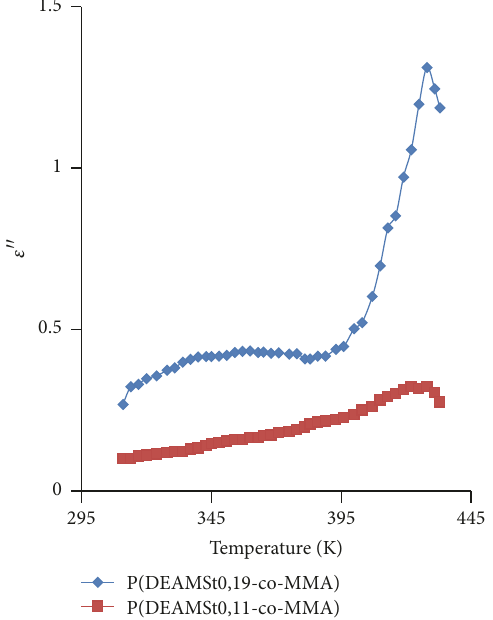
Figure 16: The graph of the dielectric loss factor change by the temperature for P(DEAMSt0.11-co-MMA) and P(DEAMSt0.19-co- MMA).